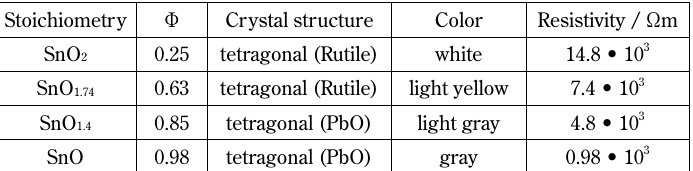
Table 1 ： Resistivity of as-synthesized tin oxide nanoparticles under ambient conditions syn- thesized at 0.98 < Φ <